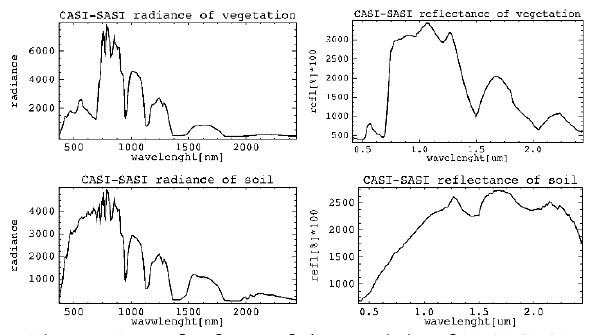
Figure 1. Example of spectral characteristics of CASI-SASI sensors after radiometric and atmospheric